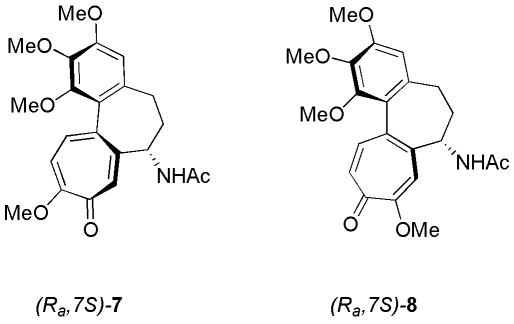
Structure of colchicine and isocolchicine.These structures represent the(R
a,7S) configuration of both colchicine (7) and isocolchicine (8).